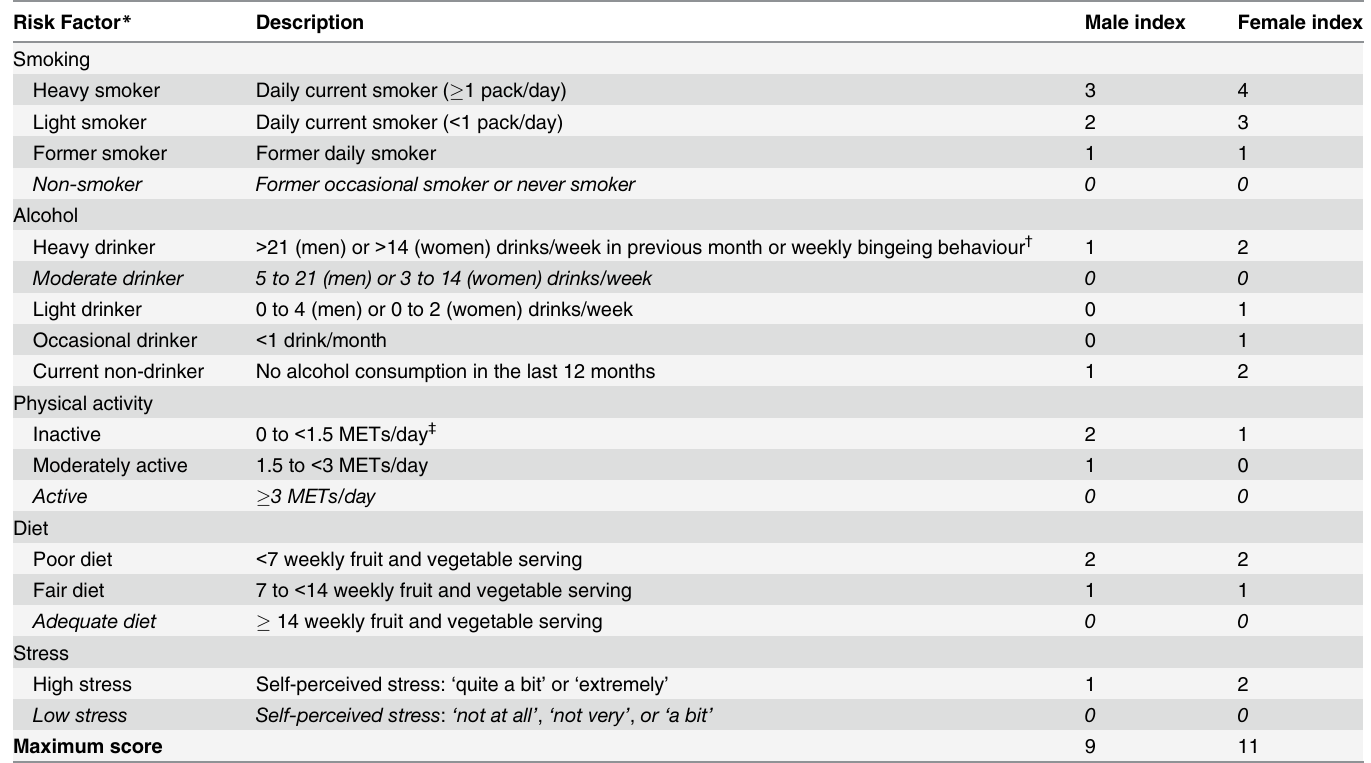
Table 1. SPoRT index of health behaviour and